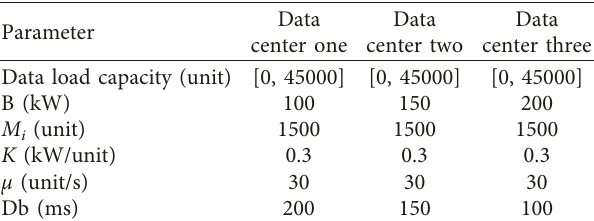
Table 4: Data center s ′ parameters.